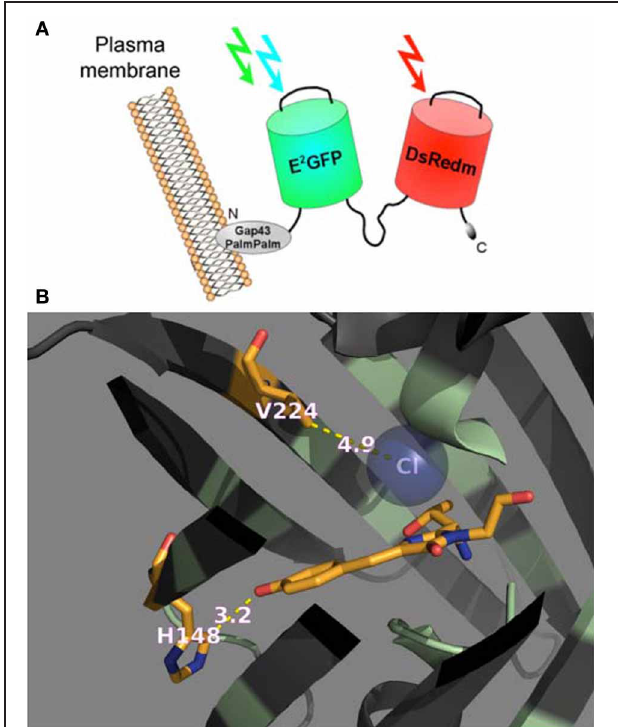
FIGURE 1 | Genetically encoded Cl − /pH-sensors used in this study. (A) Schematic representation of PalmPalm-ClopHensor. (B) A cartoon representing the specific Cl − -binding site in the newly developed H148G/V224L/T203Y variant of E 2 GFP. The residues in positions 148 and 224 as well as the chromophore are shown as stick models with the atoms colored as follow: C, orange; N, dark blue, and O, red. The Cl − ion is shown as a sphere model in transparent